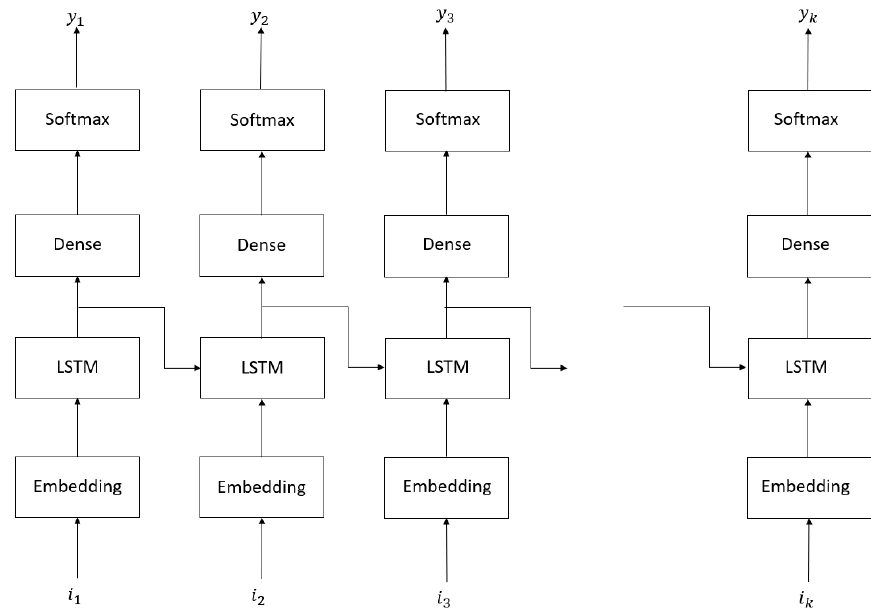
Figure 12. Seq2Seq model to detect malicious MQTT traffic.